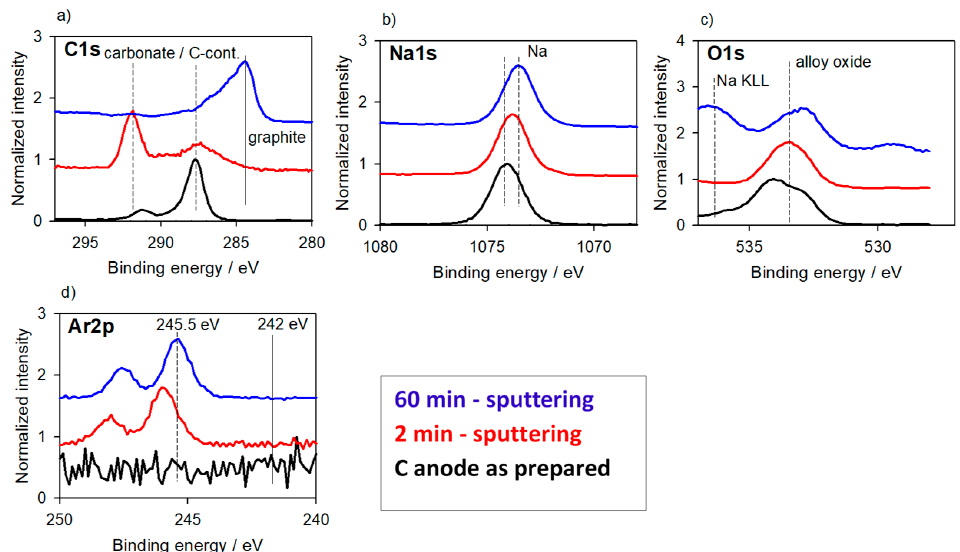
Figure 5. XP spectra normalized in intensity for a hard carbon sample electrochemically infiltrated with Na after 0, 2 and 60 min sputter cleaning ( bottom to top ). No charging; no charge compensation. At the beginning C1s for carbonate and C-H contamination is at high BE (288 eV/292 eV); in large depth the C position for hard carbon is reached (284.4 eV). Ar2p is always situated at a remarkably high BE of 245.5 eV. ( a ) C1s; ( b ) Na1s; ( c ) O1s; ( d ) Ar2p transition.